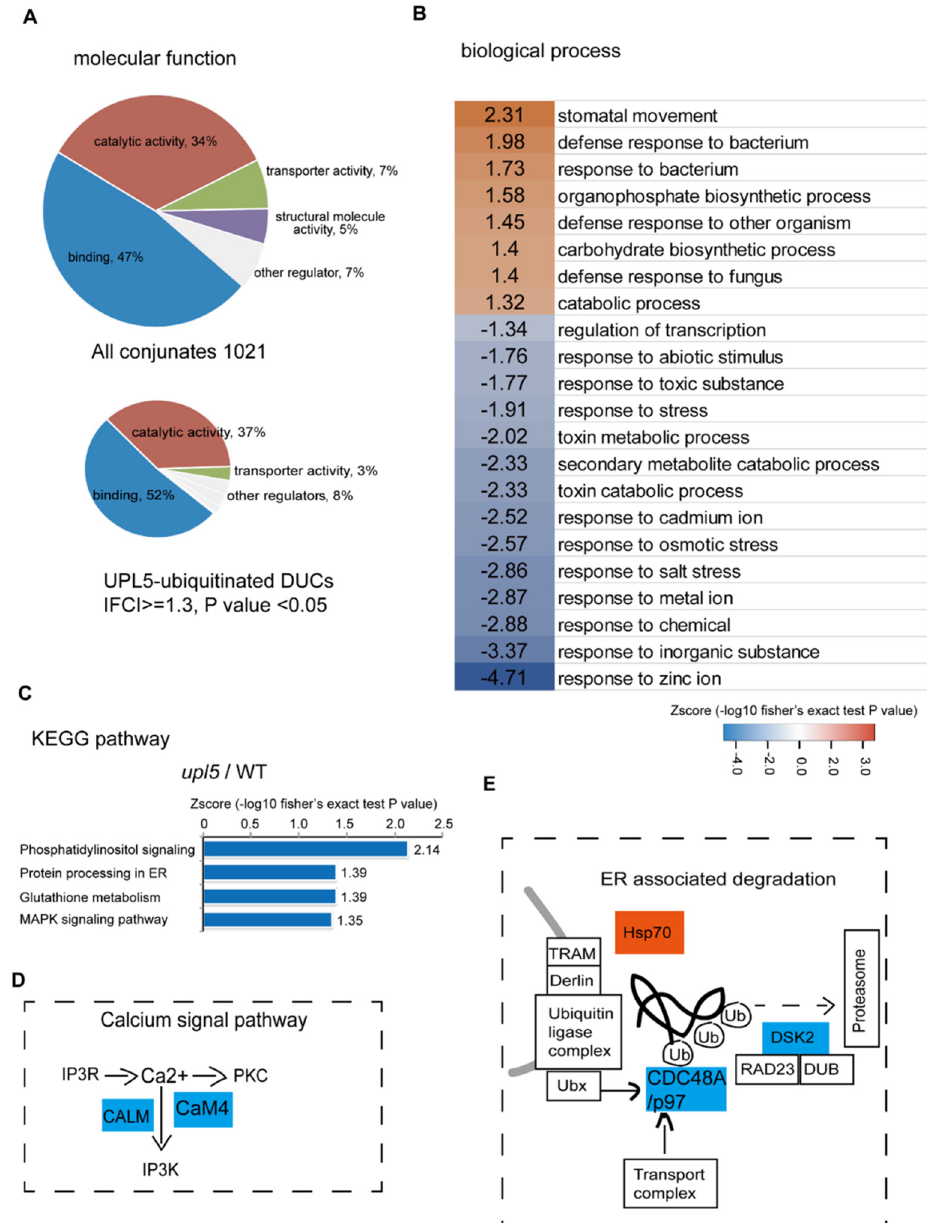
Figure 2. Gene Ontology (GO) term and KEGG pathway enrichments for the UPL5-associated ubiquitin conjugates (changed fold 1.2, p value < 0.05). ( A ) GO term enrichment in categories of molecular functions of UPL5-associated ubiquitin conjugates. ( B ) GO term enrichment in categories of biological process of UPL5-associated ubiquitin conjugates. ( C ) KEGG pathway of UPL5-associated ubiquitin conjugates differentially ubiquitinated conjugates (DUCs). ( D ) The UPL5-regulated ubiquitin conjugates of the upl5 /WT mapped in calcium signal pathway. ( E ) The UPL5-regulated ubiquitin conjugates of the upl5 /WT mapped in endoplasmic reticulum (ER) associated degradation pathway.